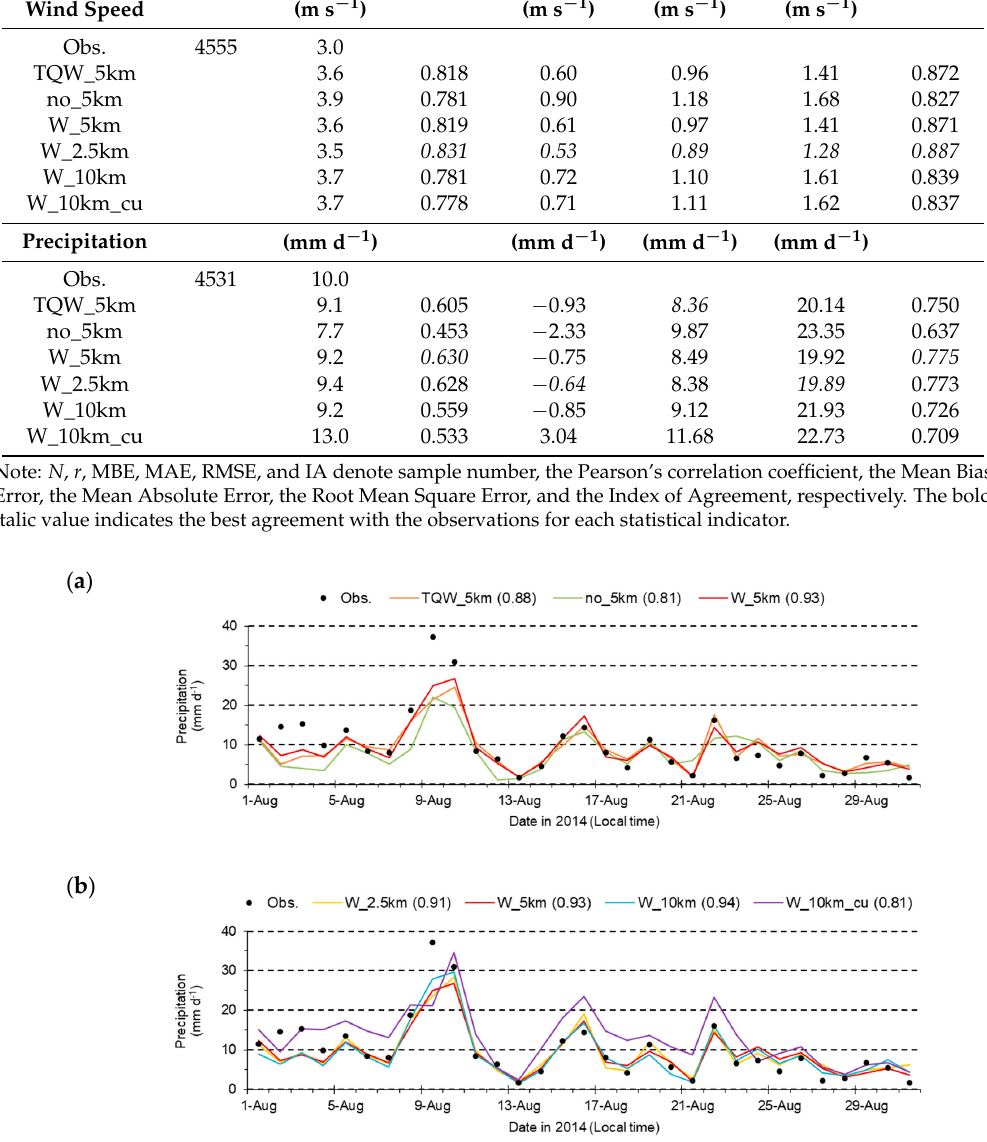
Figure 2. Temporal variations of daily precipitation averaged for all the meteorological observatories in August 2014 for the comparison of ( a ) the grid nudging, and ( b ) the horizontal resolution and the cumulus scheme. Values in parentheses are the Pearson’s correlation coefficients between observed and simulated daily precipitations averaged for all the observatories.